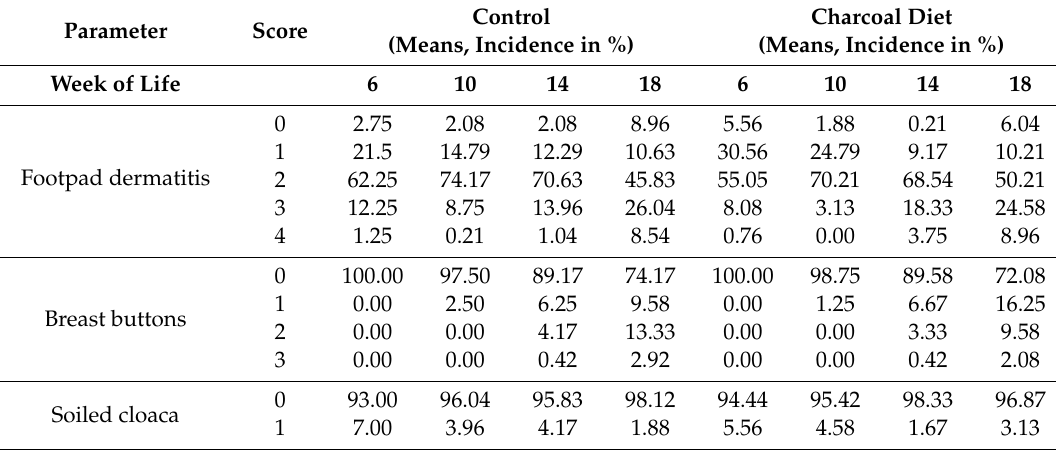
Table 6. Results of the scored health parameters of the BUT6 turkey toms in Experiment 1, percentage of each score per parameter (%) at the observations in weeks 6, 10, 14 and 18 of life ( n = 3 farms, n = 6 batches, n = 918 turkeys in charcoal diet, n = 920 in